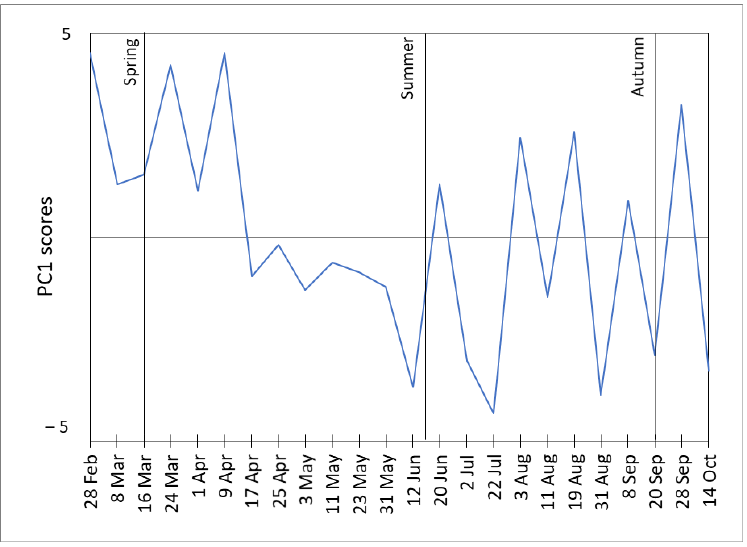
Figure 6. Temporal trend of the PC1 scores obtained by means of Principal Component Analysis on the results of the sequential extraction.